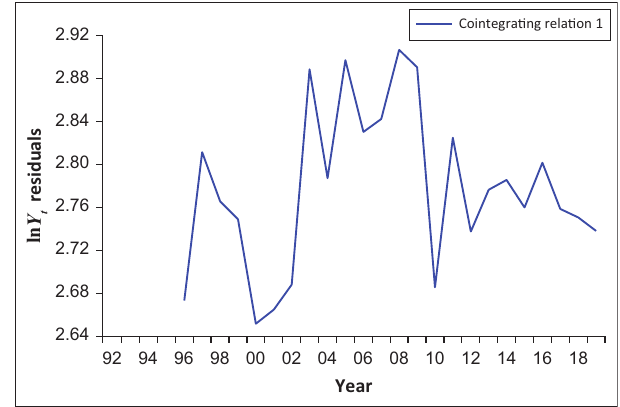
FIGURE 9: Cointegration relationship, vector error correction model.